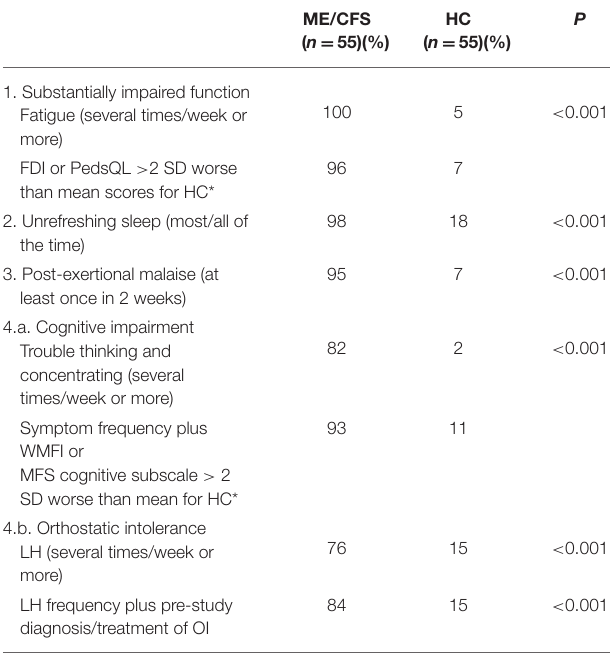
TABLE 5 | Prevalence of Institute of Medicine ME/CFS